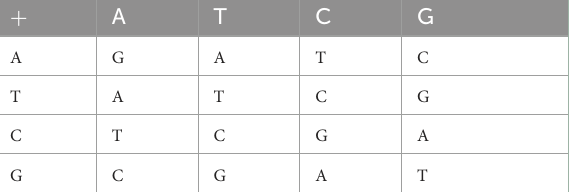
TABLE 4 DNA subtraction rules (corresponding to DNA encoding/decoding rule no. 4).